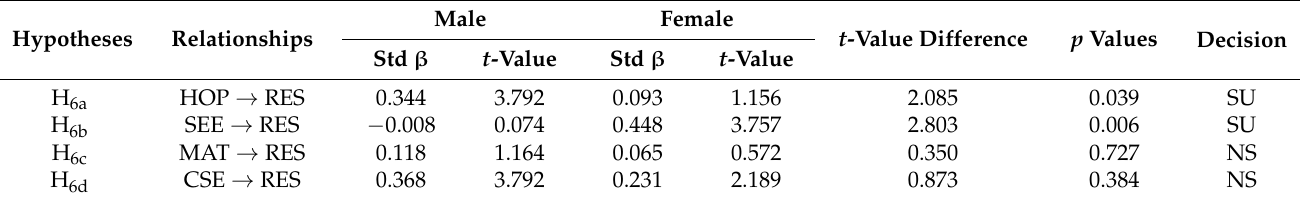
Table 6. Partial least squares results for the moderating effects of